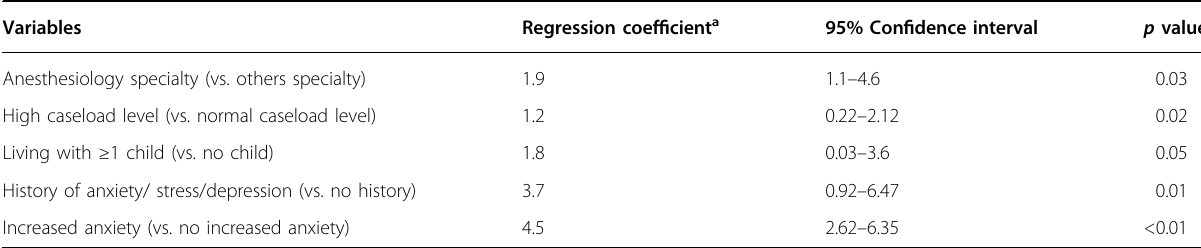
Table 3 Multivariate analysis.